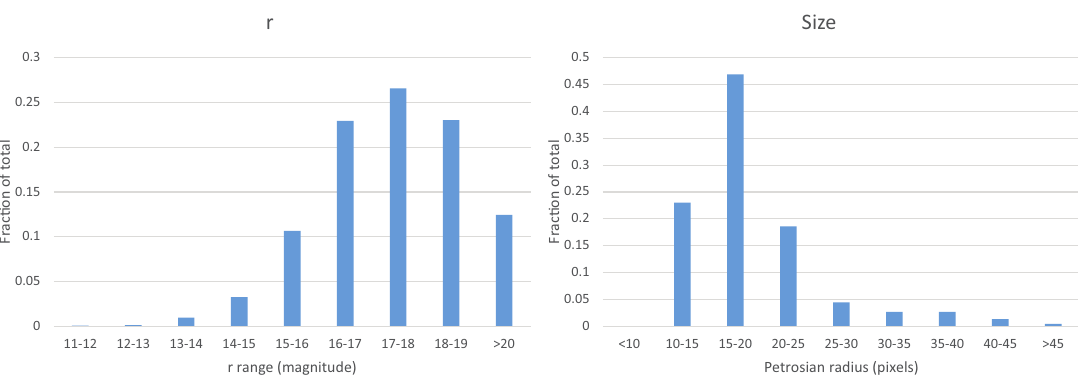
Figure 3. Spectroscopic redshift distribution of the galaxies in the catalog of broad galaxy